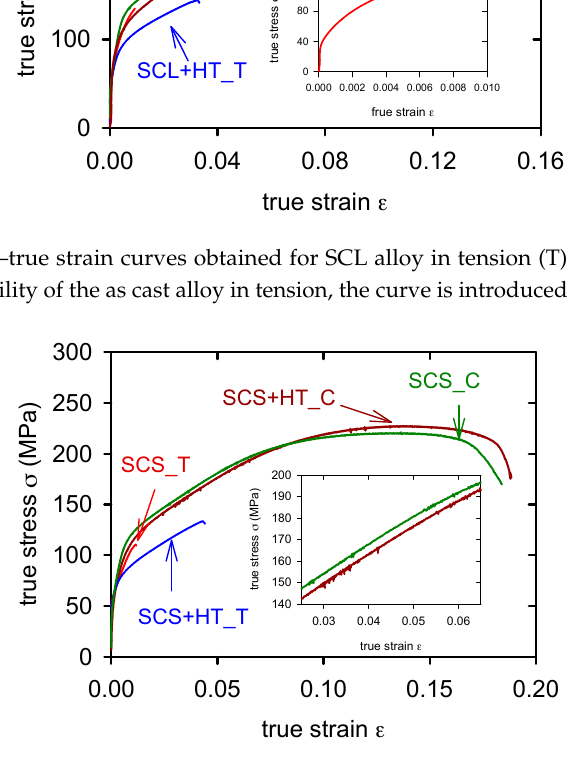
Figure 8. True stress–true strain curves obtained for SCS alloy in tension (T) and compression (C). Serrated flow estimated in compression is obvious from the insert.